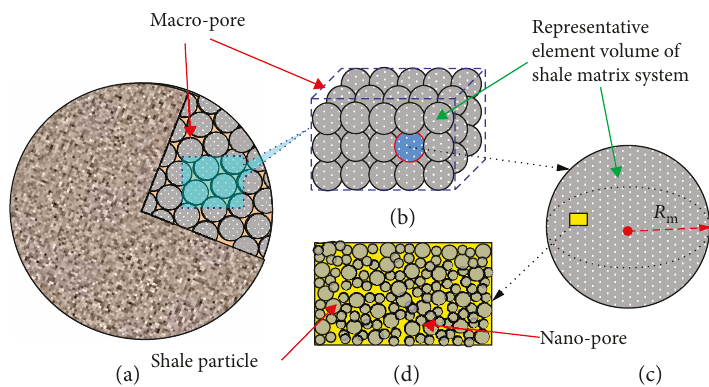
Figure 4: Conceptual model used in this paper.